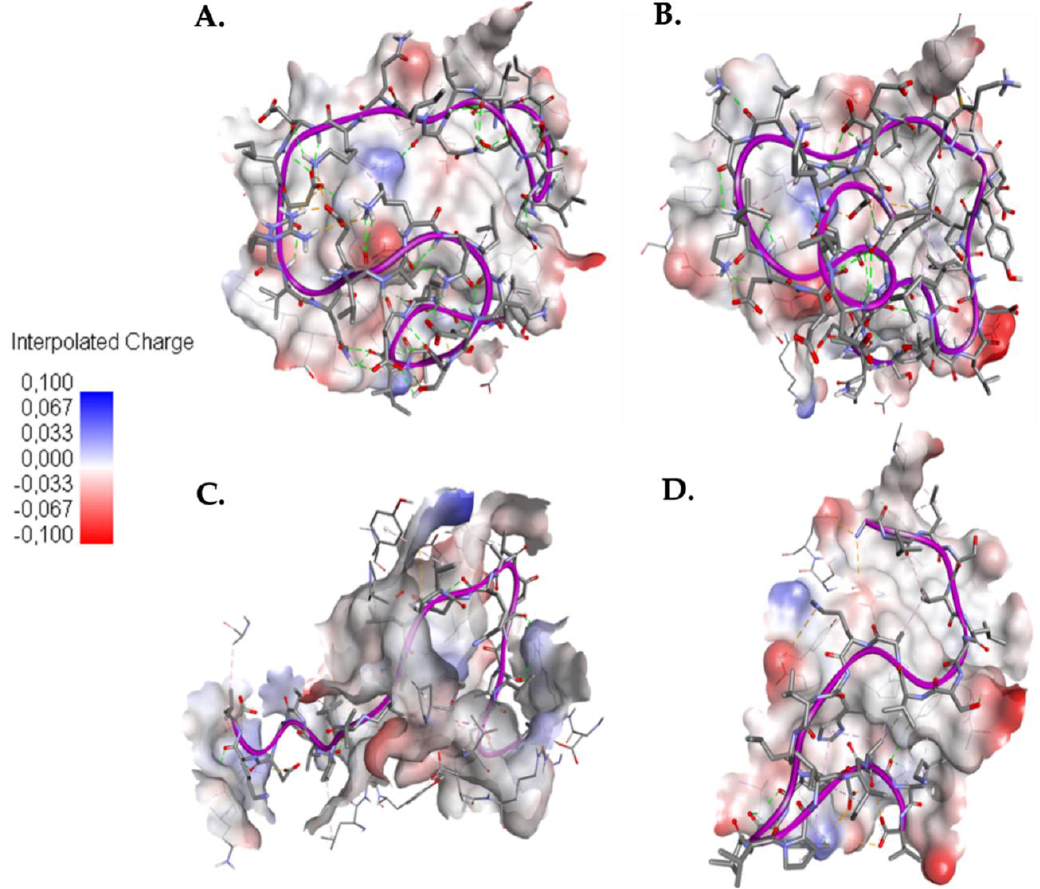
Figure 5. Docking between AMPs and the cell host receptor ACE2. ( A ) Interaction between SARS-CoV-HR2P and ACE2; ( B ) Interaction between EK1 and ACE2; ( C ) Interaction between caerin 1.6 and ACE2; ( D ) Interaction between caerin 1.10 and ACE2. Red indicates negative charge and blue indicates positive charge of the ACE2 binding site.